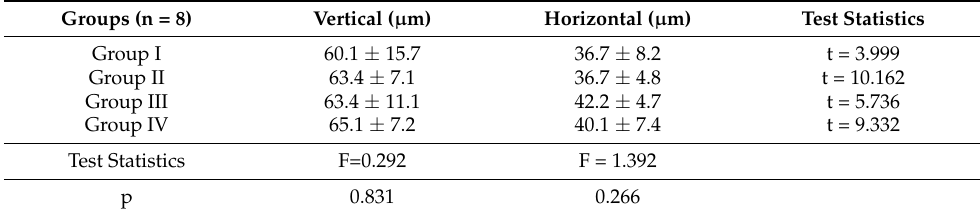
Table 3. Comparison of the mean values of the vertical and horizontal dimensions of the m. iliocau- dalis muscle according to the